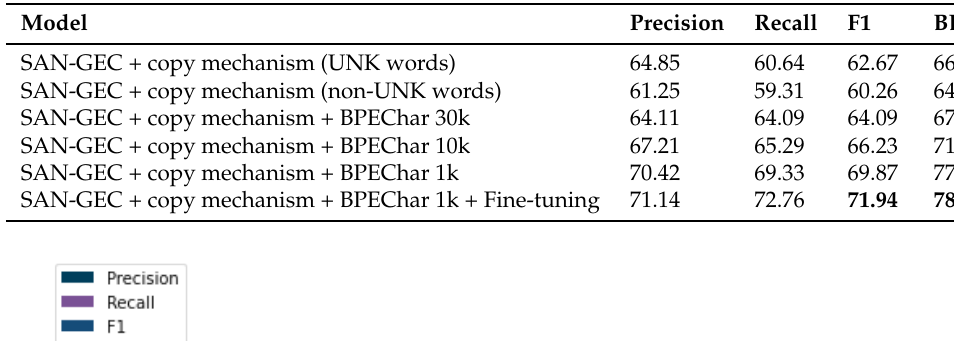
Table 4. The impact of the copy mechanism, different settings for BPEChar and fine-tuning the IGEC framework, the bold refers to state-of-the-art values.